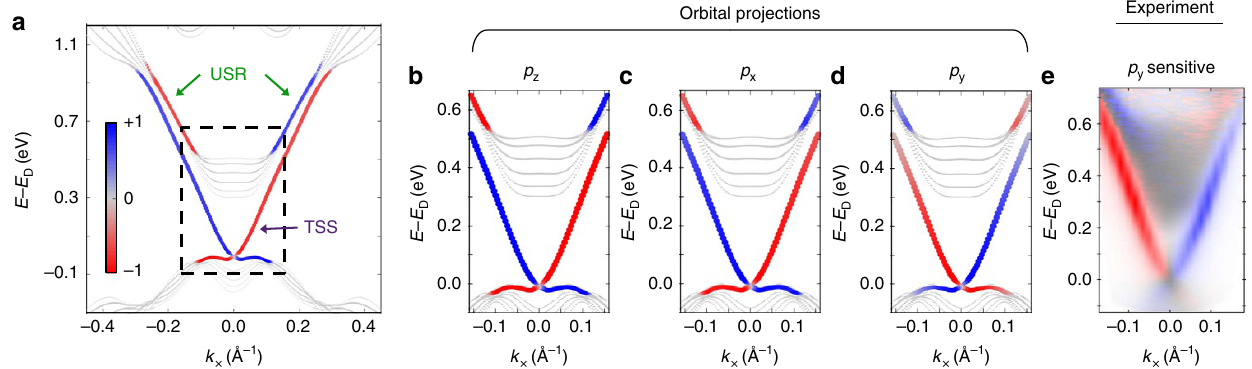
Figure 4 | Density functional theory calculations of the spin resolved electronic structure along C -K. ( a ) The marker sizes denote the magnitude of the projection of each state onto the top quintuple layer of the slab, whereas the colors denote the spin-polarization as indicated by the colorscale. Small gray markers therefore show unpolarized bulk-like bands, while large blue/red markers show surface-localized bands, such as the topological surface state (TSS) and unoccupied surface resonance (USR), with spin polarization along the k y axis. The energy scale is referenced to the Dirac point energy, E D . ( b – d ) Same as previous panel, projected onto p z , p x , and p y orbitals, respectively. ( e ) The experiment was performed with s -polarized probe photons, and therefore can be compared to the p y projected calculation.